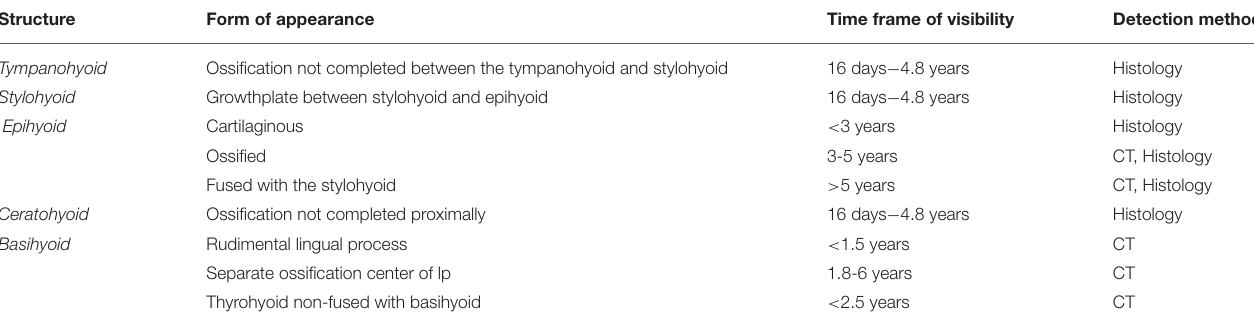
TABLE 2 | Form of appearance, time frame of their visibility, and detection method of this appearance of the different components of the hyoid